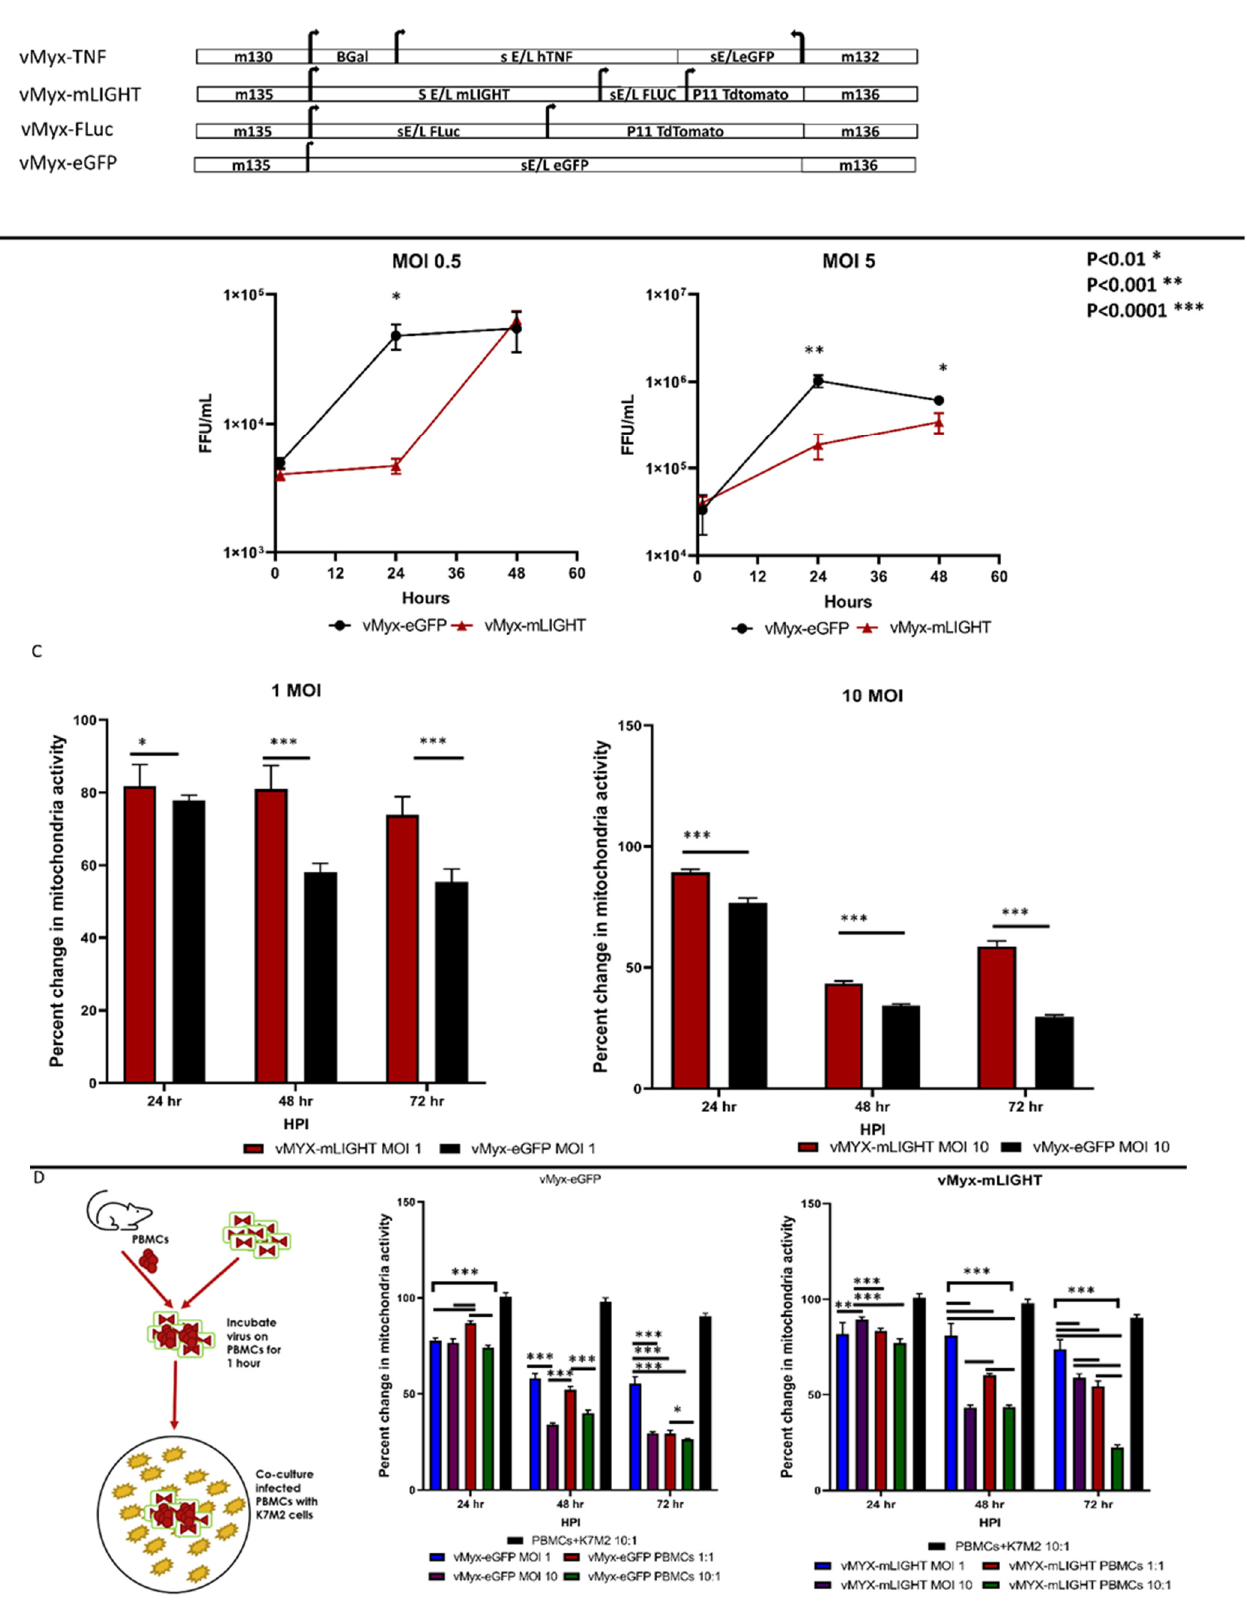
Figure 1. Transgene-dependent changes in replication and induced cytotoxicity efficiency of transgene armed-myxoma virus in K7M2-luc osteosarcoma cells in vitro. ( A ) Diagram of viruses primarily used in these studies. The M numbers indicate the open reading frames in the MYXV virus genome.